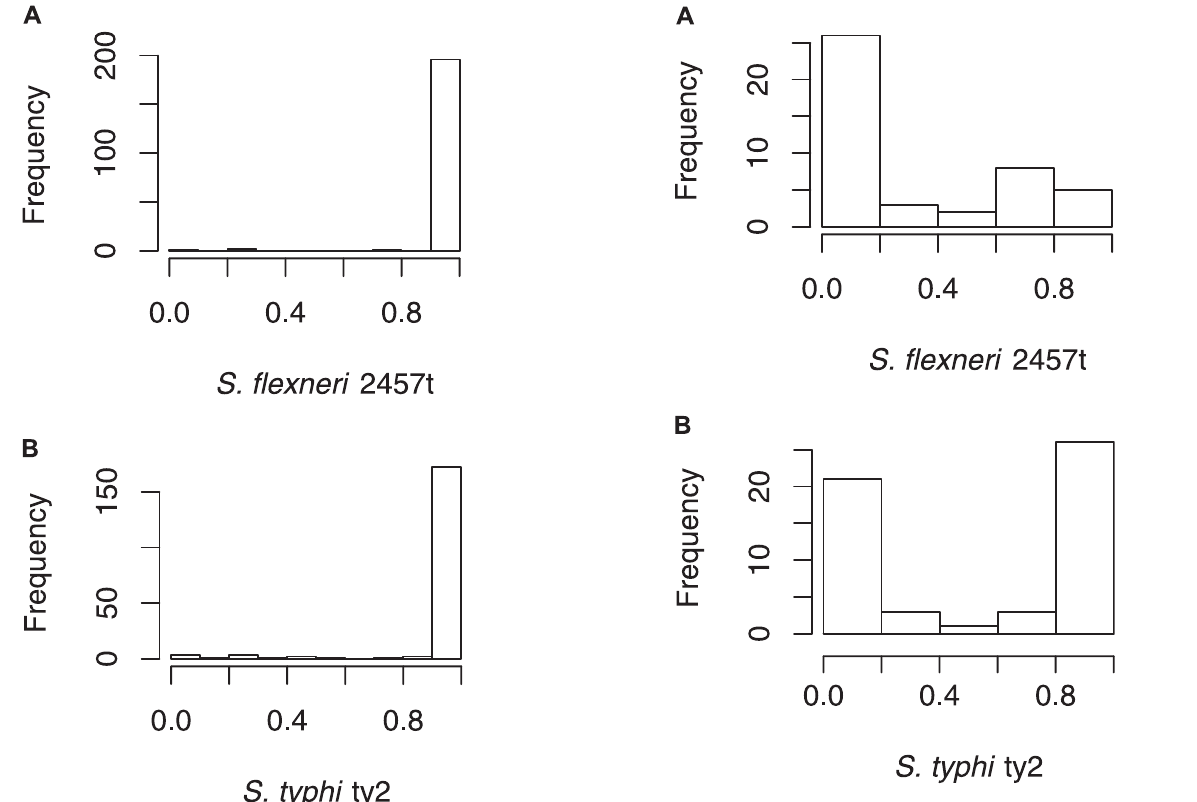
Figure 11. Histogram of Length Ratios between Significant Overlaps (after Removing Nuisance Cross-Overlaps) in the Comparison of S. flexneri 2457t and S. typhi ty2 Given two entries that significantly overlap, the ratio between the smallest entry to the largest one is calculated. For identifying significant overlaps we use dupPerc ¼ 50%. (A) Ratios in S. flexneri 2457t and (B) ratios in S. typhi ty2. We set the default value of orthPerc to 50%, where the minimum in both histograms